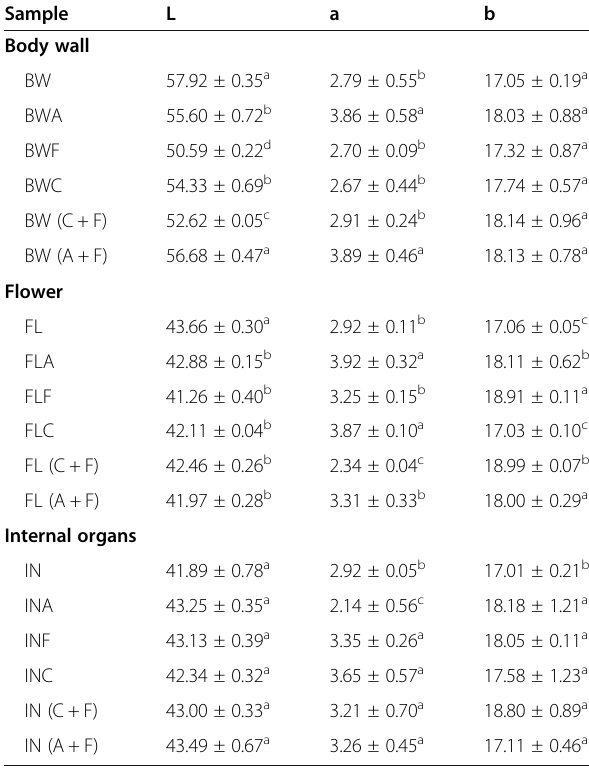
L, whiteness; a, redness; b, yellowness; BW Body wall, FL Flower, IN Internal organs, A Alcalase, F Flavourzyme, C Corolase, C+F Mixture of Corolase and Flavourzyme, A+F Mixture of Alcalase and Flavourzyme; Data are expressed as means ±SD from triplicate determinations Different superscripts in each column for the same colour parameter of protein hydrolysates prepared from each body part indicates significant difference at p <0.05